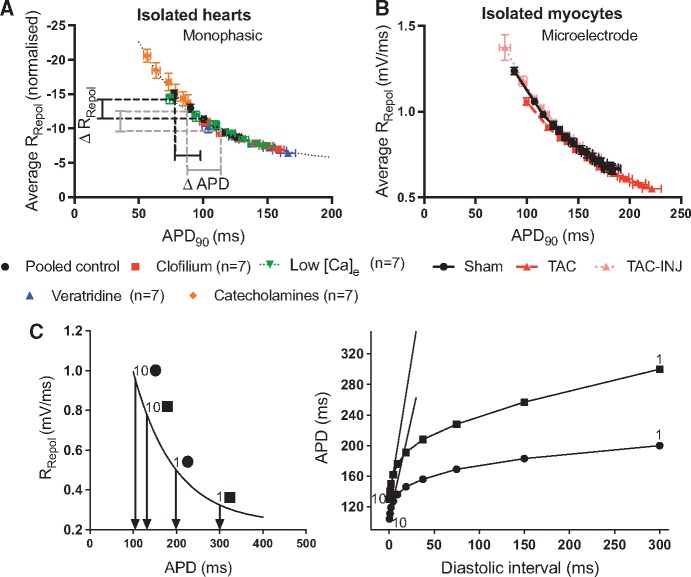
Modelling the influence of action potential duration on the electrical restitution curve. (A) Data demonstrating that mono-phasic action potential duration (APD90) is related in a non-linear manner to the average rate of repolarization (RRepol) in isolated guinea pig hearts. (B) The same relationship is shown in microelectrode recordings from isolated ventricular myocytes. Data represent mean ± SEM at each pacing cycle length. (C) The non-linear relation between the average RRepol and APD predicts that prolongation of the action potential will act to steepen the restitution curve (see text for details). Panel C adapted with permissions from Winter and Shattock (2016).25